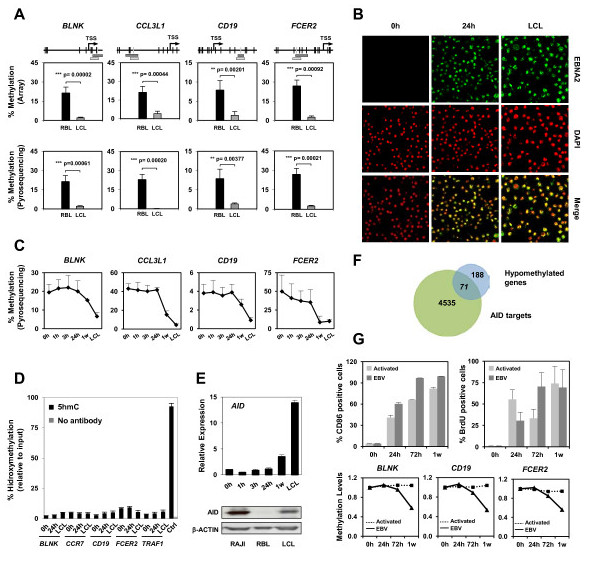
A comparison of the DNA methylation levels of selected genes between RBLs and resulting LCLs. (a) Bisulfite pyrosequencing was performed for the genes selected from experiments with methylation arrays. The distribution of CpG sites (vertical black line), the transcription start site (TSS; arrow) and the exact CpGs analyzed by the array (horizontal light grey bar) and pyrosequencing (horizontal dark grey bar) are indicated above each gene. Average data from six samples is represented. (b) EBNA2 and DAPI staining of B lymphocytes at 0 and 24 hours after infection with EBV derived from 293 cells carrying a recombinant B95.8 EBV genome, and LCLs, in which high levels of infection were achieved. (c) Pyrosequencing data showing the methylation changes at selected genes at different times. (d) Analysis of the 5-hydroxymethylcytosine content/changes at CpG sites undergoing hypomethylation in selected genes. As a positive control, in vitro hydroxymethylated DNA was used. (e) Changes in expression of activation-induced deaminase (AID) during RBL conversion to LCLs at the mRNA and protein levels. For protein analysis, the Burkitt's lymphoma cell line RAJI was used as a positive control for AID expression. (f) Overlap between AID target genes and hypomethylated genes. (g) Comparison between B cells activated with IL4 and CD40L and infected with EBV. The top panel shows the proportion of activated cells (left; determined by fluorescence-activated cell sorting (FACS) analysis with CD86) and proportion of dividing cells (right; determined with bromodeoxyuridine (BrdU)). Bottom, bisulfite pyrosequencing analysis of selected CpGs in association with EBV infection and with B cell activation by IL4 and CD40L. W, week.